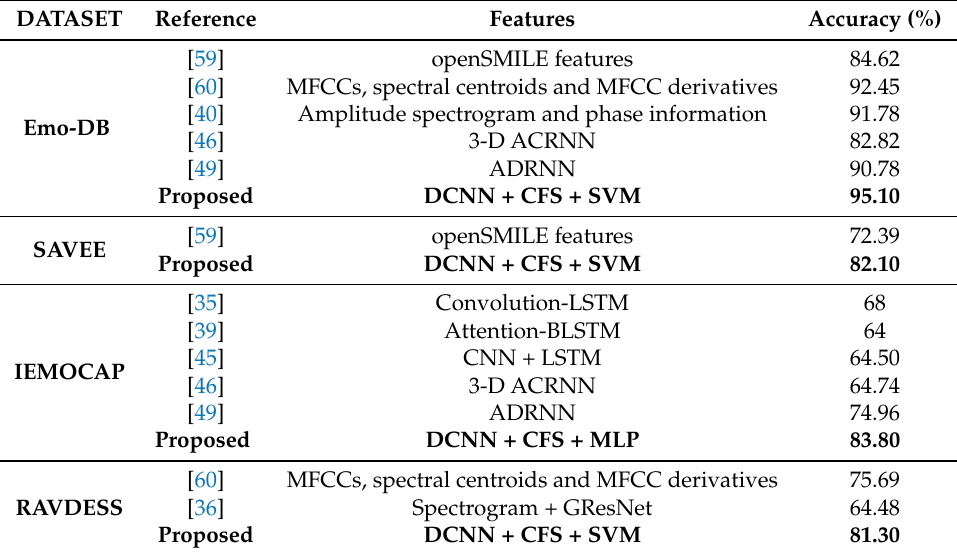
Table 5. Comparison of speaker-dependent experiments with state-of-the-art approaches.